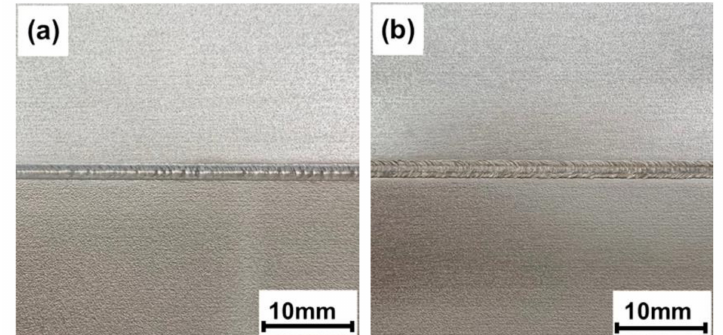
Figure 2. Appearance of weld: ( a ) joint 4 and ( b ) joint